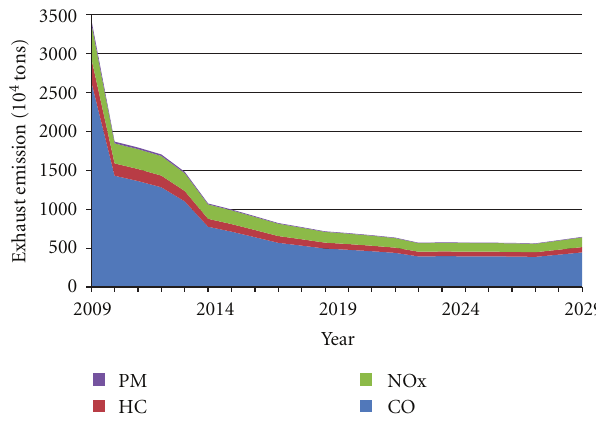
Figure 8: Forecast curve of China’s exhaust emissions under the implementation of Standard V in Scenario A.